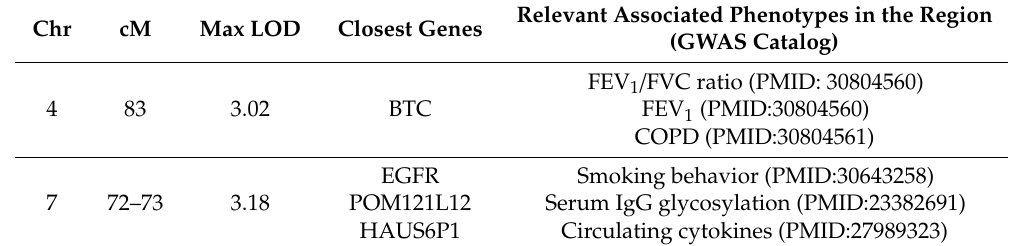
Table 5. Significant loci (LOD score > 3) from linkage analysis. Associated phenotypes in the region extracted from the GWAS catalog are included in the last